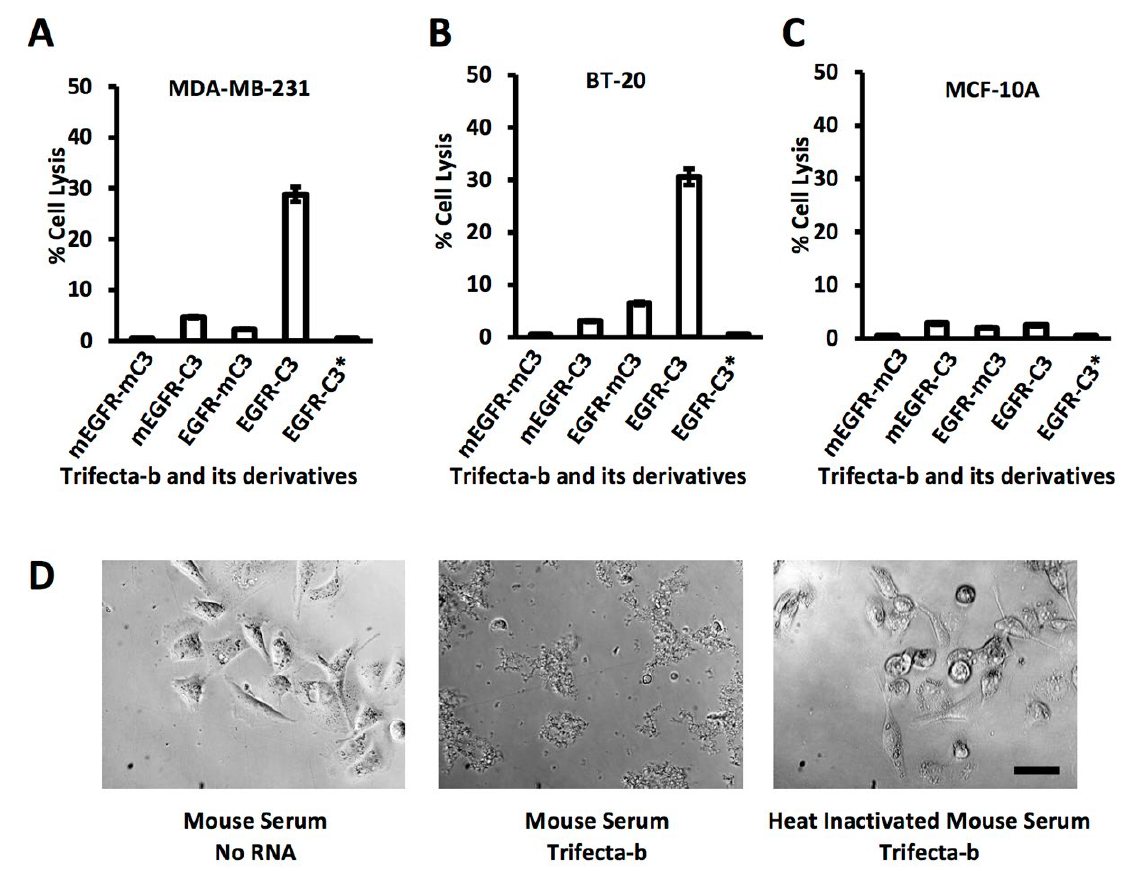
Figure 6. Aptamer-dependent reduction in target cell viability. ( A – C ) Lysis of MDA-MB-231, BT-20 and MCF-10A cells in the presence of Trifecta-b and its mutated variants. Cell viability was measured using crystal violet assays. Trifecta-b and its mutated variants are indicated by the activity of each aptamer domain in the bi-valent construct. “m” indicates inactivating mutation. The asterisk indicates the use of heat inactivated serum in the assay. Reduction in crystal violate retention by living cells attached to surface was plotted. Values are shown in the bar graphs ( n = 3 and error is standard deviation). ( D ) Viability of MDA-MB-231 cells in the presence of Trifecta and mouse serum. Micrographs of MDA-MB-231 cells are at 200 × magnification. Scale bar indicates 50 µ m. Experiments were repeated 3